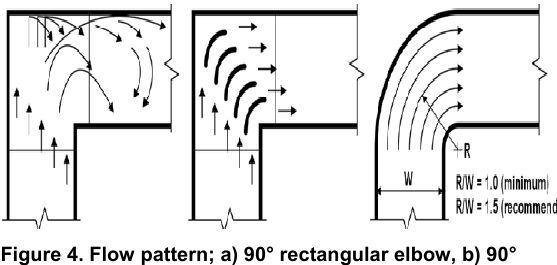
Figure 4. Flow pattern; a) 90° rectangular elbow, b) 90° rectangular elbow with turning vanes, c) 90° elbow with a moderate radius